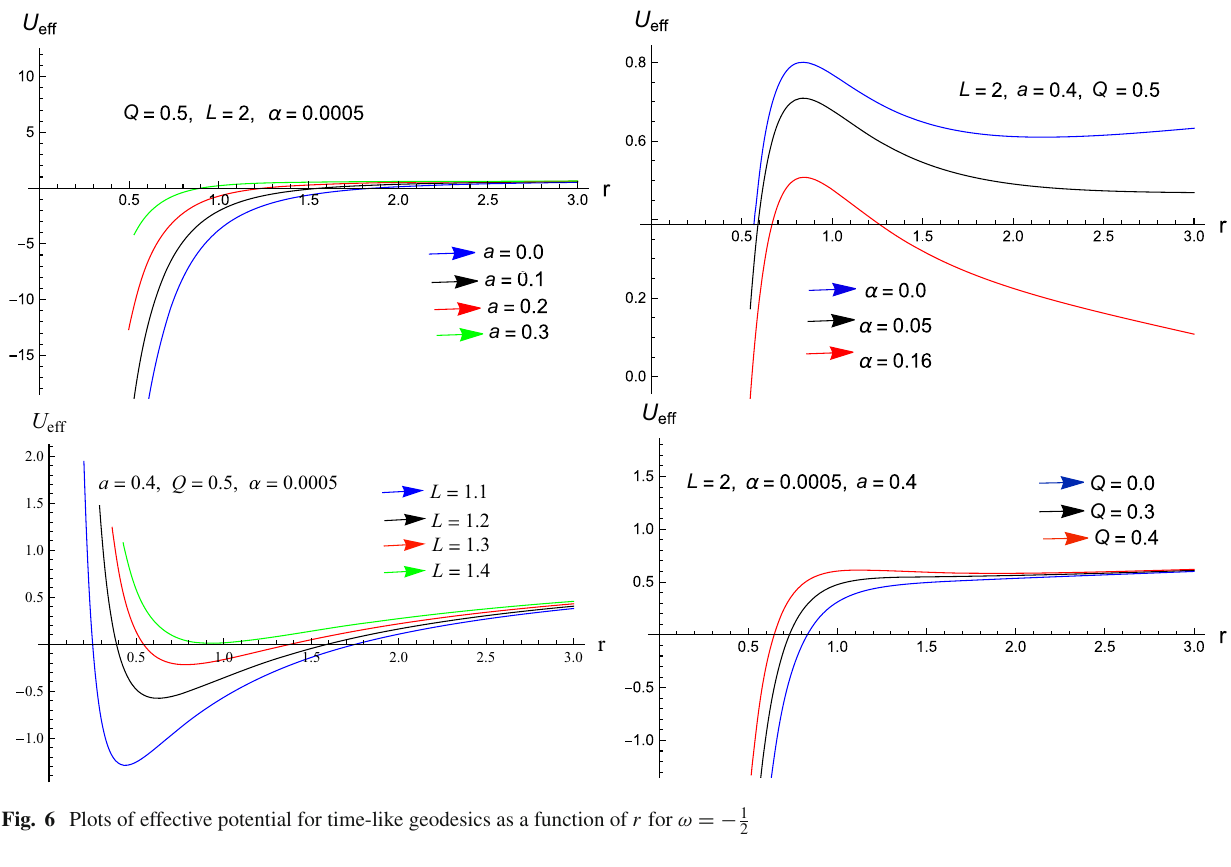
Fig. 6 Plots of effective potential for time-like geodesics as a function of r for ω = − 1